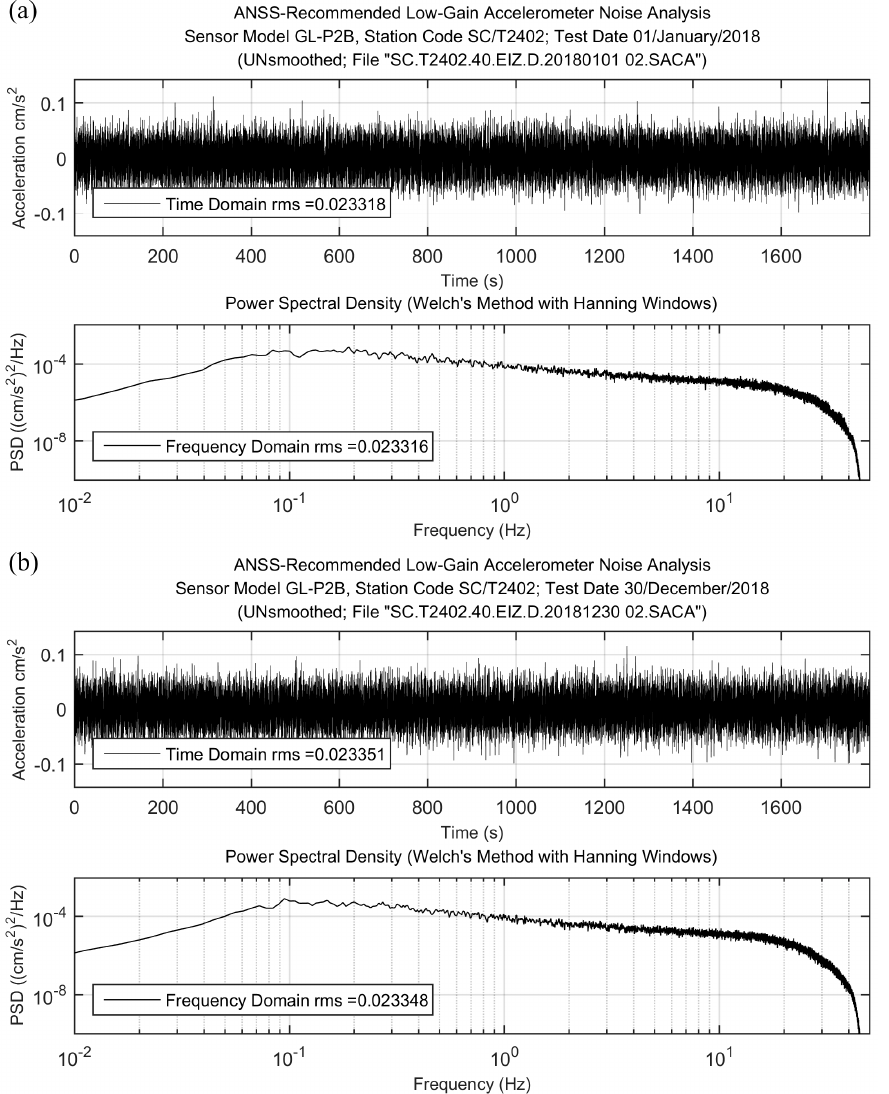
Figure 4. An example of noise data of the sensor SC / T2402 processed by a Butterworth bandpass filter between 0.1–20 Hz and the computed root mean square (RMS), power spectral density (PSD) values: ( a ) Results of the noise data obtained on 1 January 2018; ( b ) results of the noise data obtained on 30 December 2018.